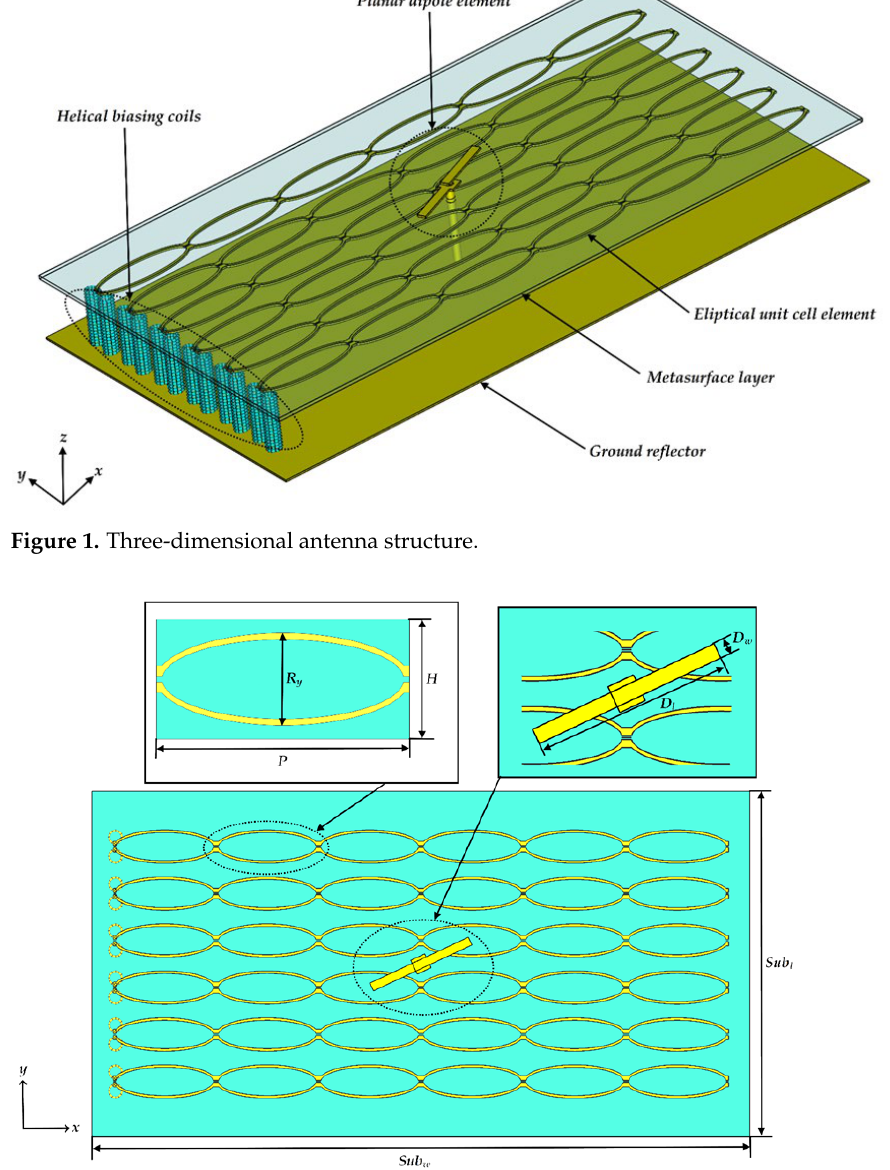
Figure 1. Three-dimensional antenna structure.